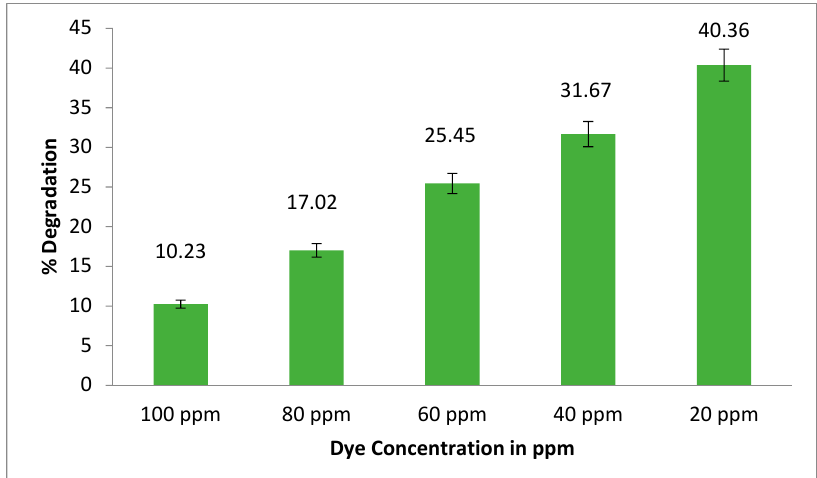
Figure 3. Dye concentration effect on the % degradation of brown 706.